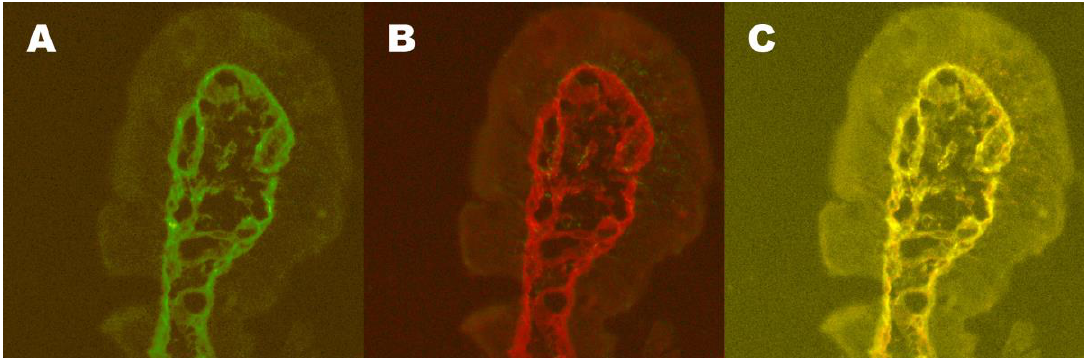
Figure 2. Small intestinal mucosal immunoglobulin (Ig) A deposits are shown in a villus tip from a dermatitis herpetiformis patient with normal mucosal morphology. IgA is stained with green ( A ), transglutaminase 2 (TG2) with red ( B ), and subepithelial colocalisation of IgA and TG2 can be seen in yellow ( C ).